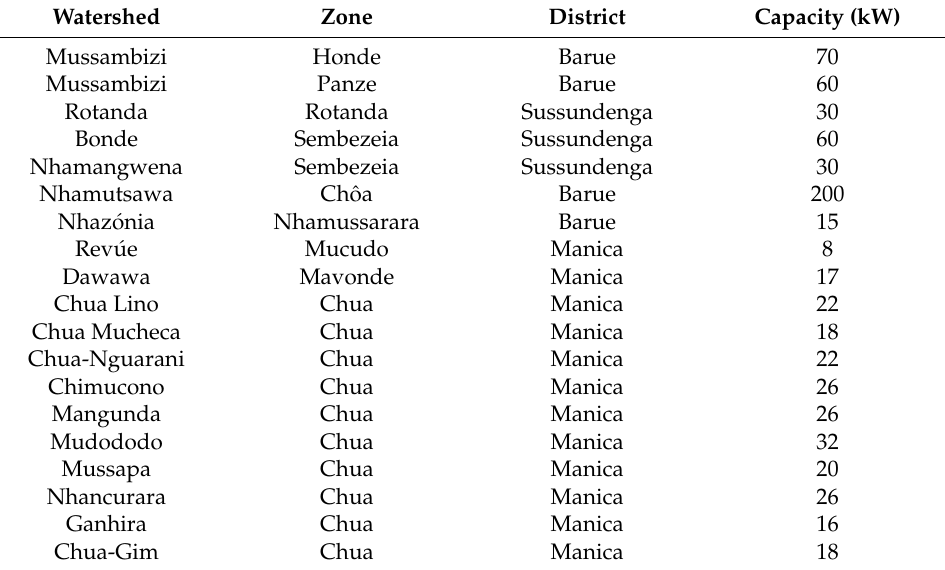
Table 1. Potential small hydropower plants in Manica Province [4]. Zone